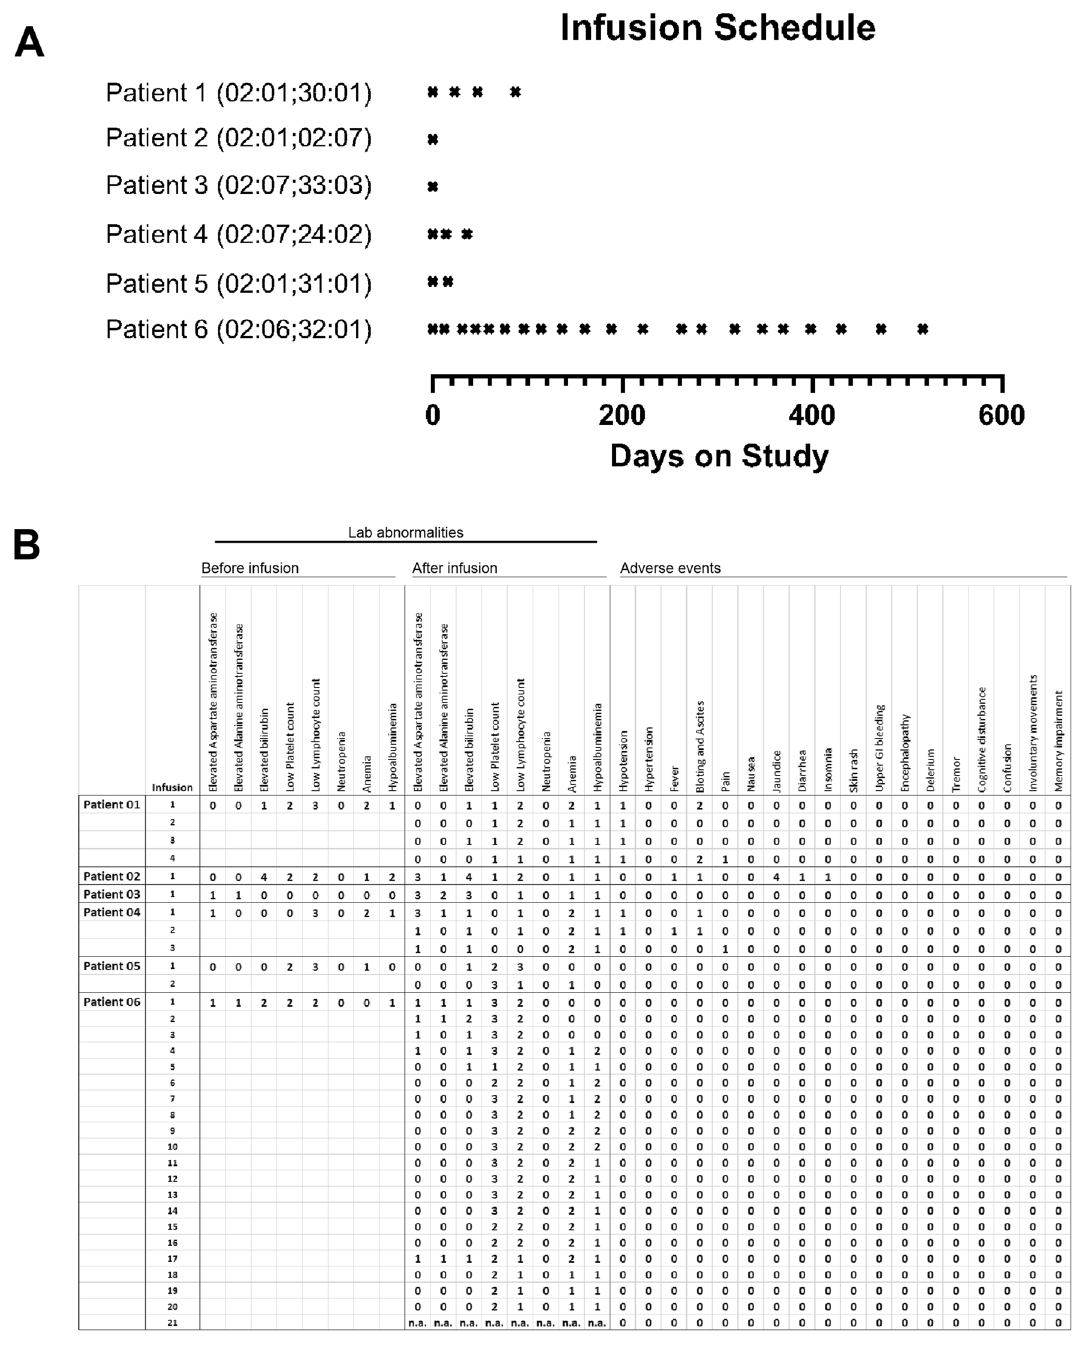
Figure 3. AbTCR + co-stim T cell therapy is safe in humans. ( A ) Six HCC patients with indicated HLA-A*02 genotypes were dosed as shown over a 17-month period. ( B ) Lab abnormalities were systematically recorded before the first infusion and immediately after each infusion along with adverse events. Grades are based on the CTCAE scale of 0–5; grade 0 means that physiological measurements were within normal range or that an adverse event was not